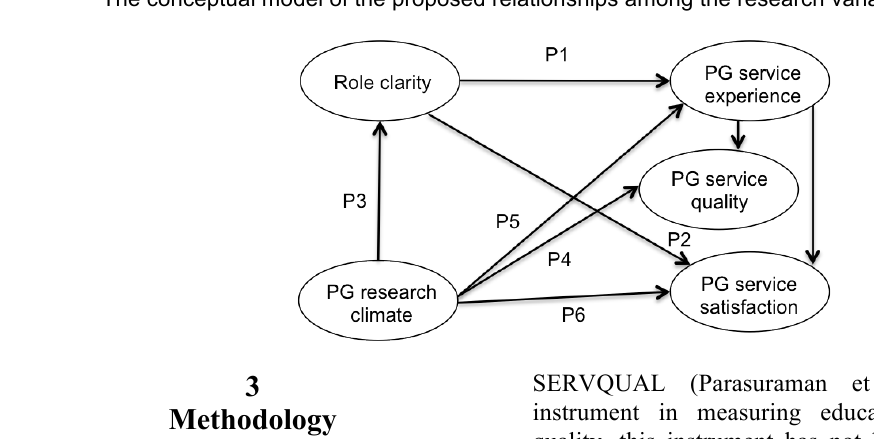
The conceptual model of the proposed relationships among the research